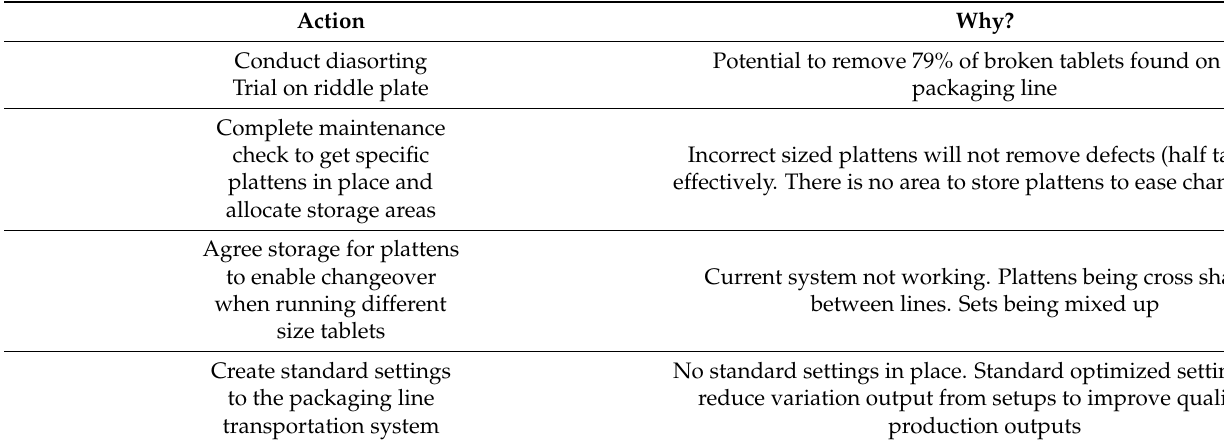
Table 2. Key corrective and preventative actions.